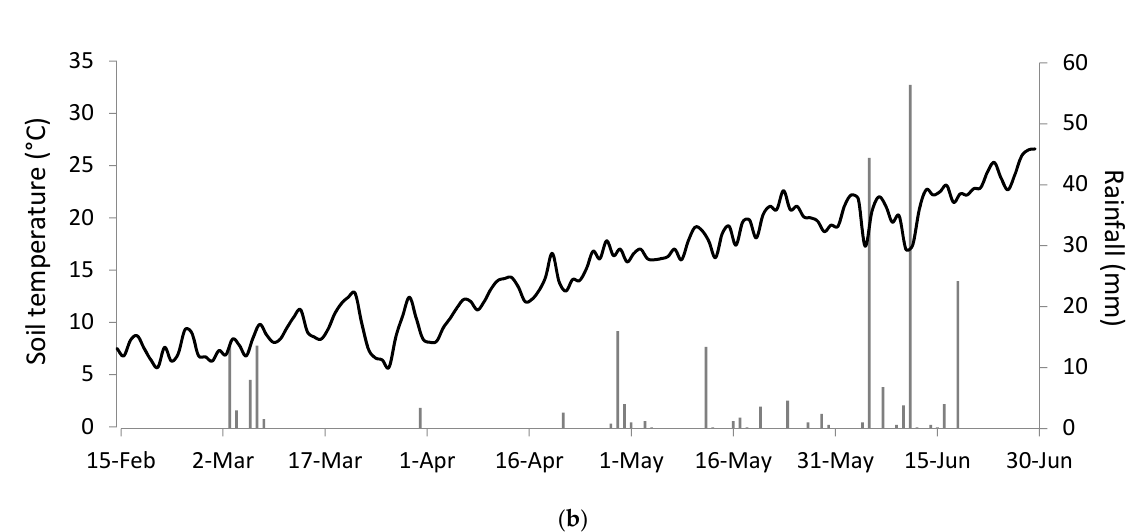
Figure 4. Daily soil temperature and precipitations in 2019 ( a ) and 2020 ( b ).